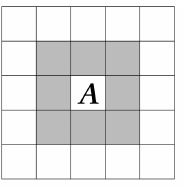
Figure 4. Block-neighborhood tampering